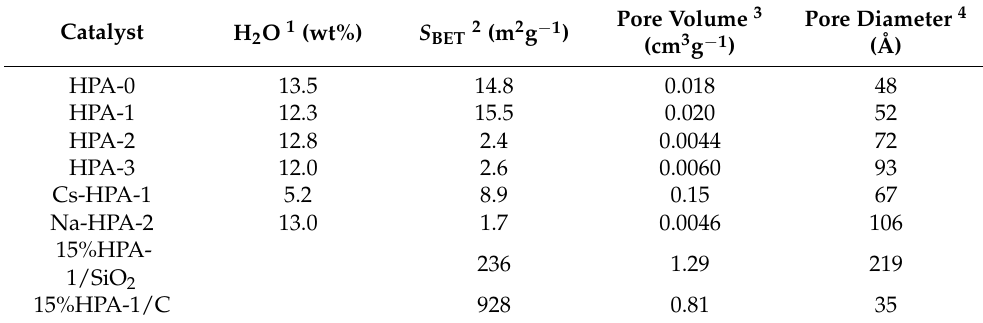
Table 1. Information about catalysts.